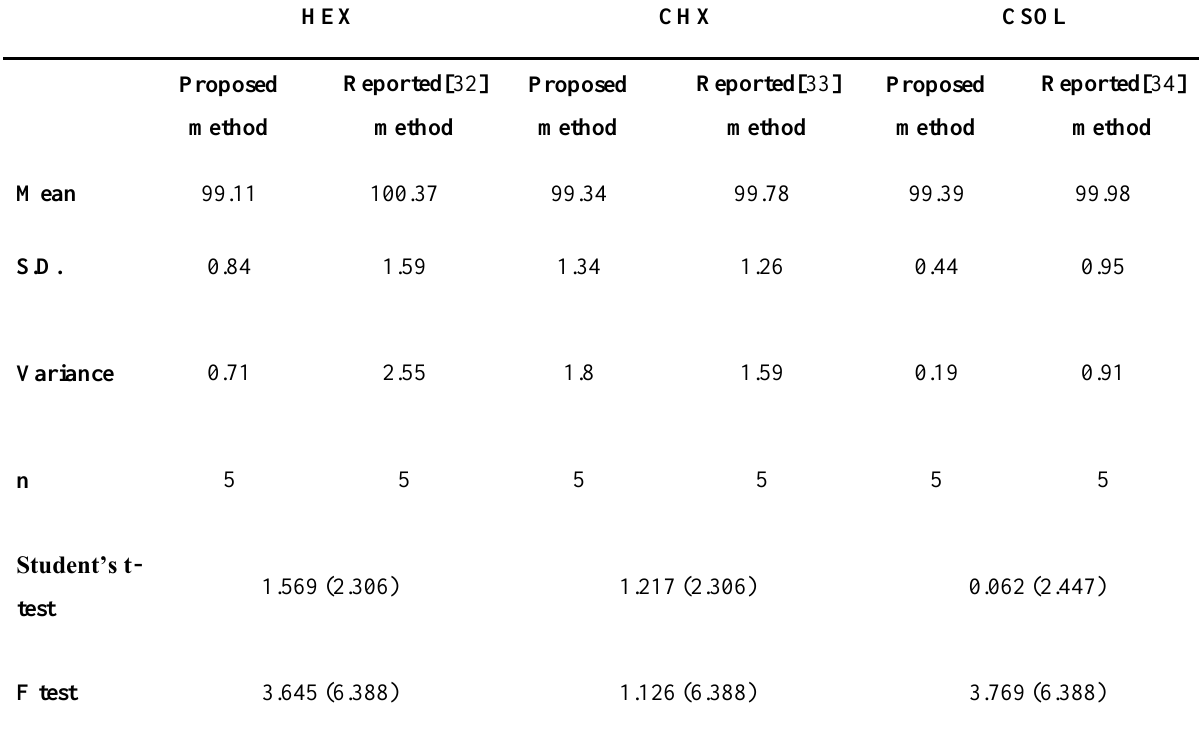
Table 8. Statistical comparison of the results obtained using the proposed HPLC method versus the reported methods for HEX, CHX, and CSOL